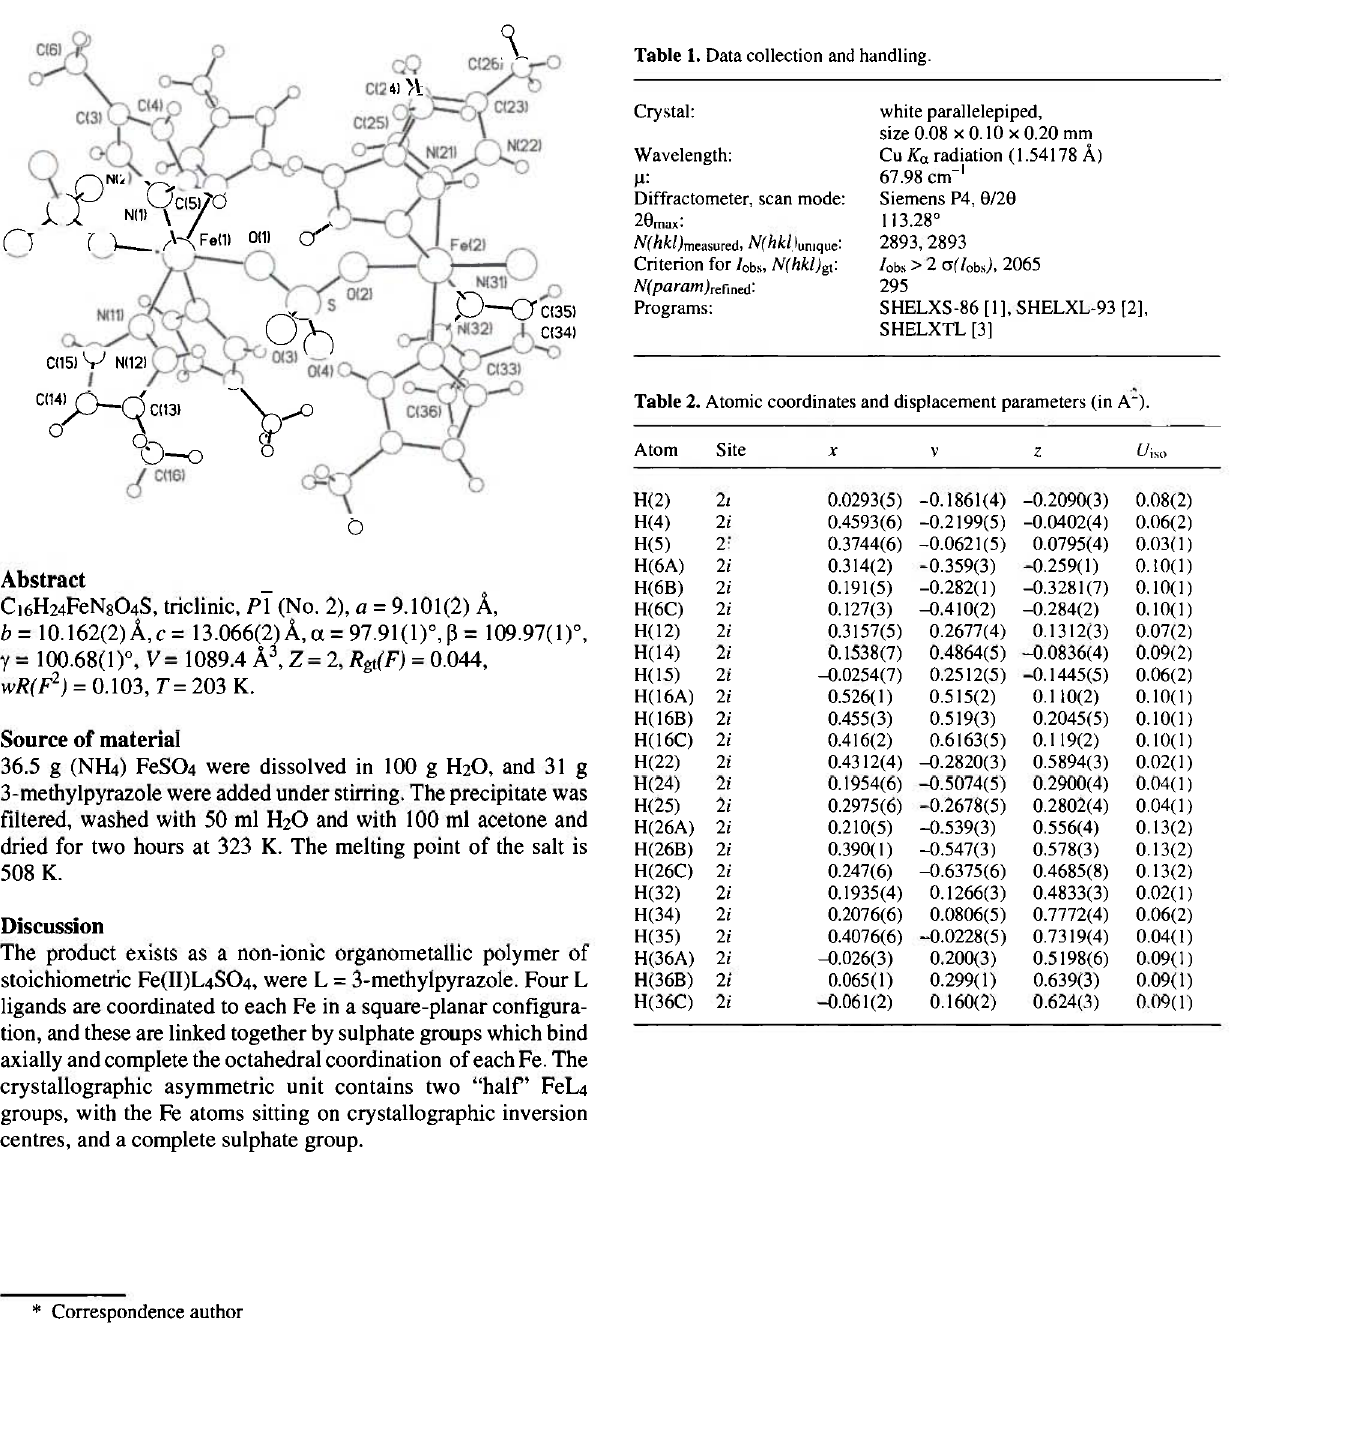
Table 1, Data collection and handling.